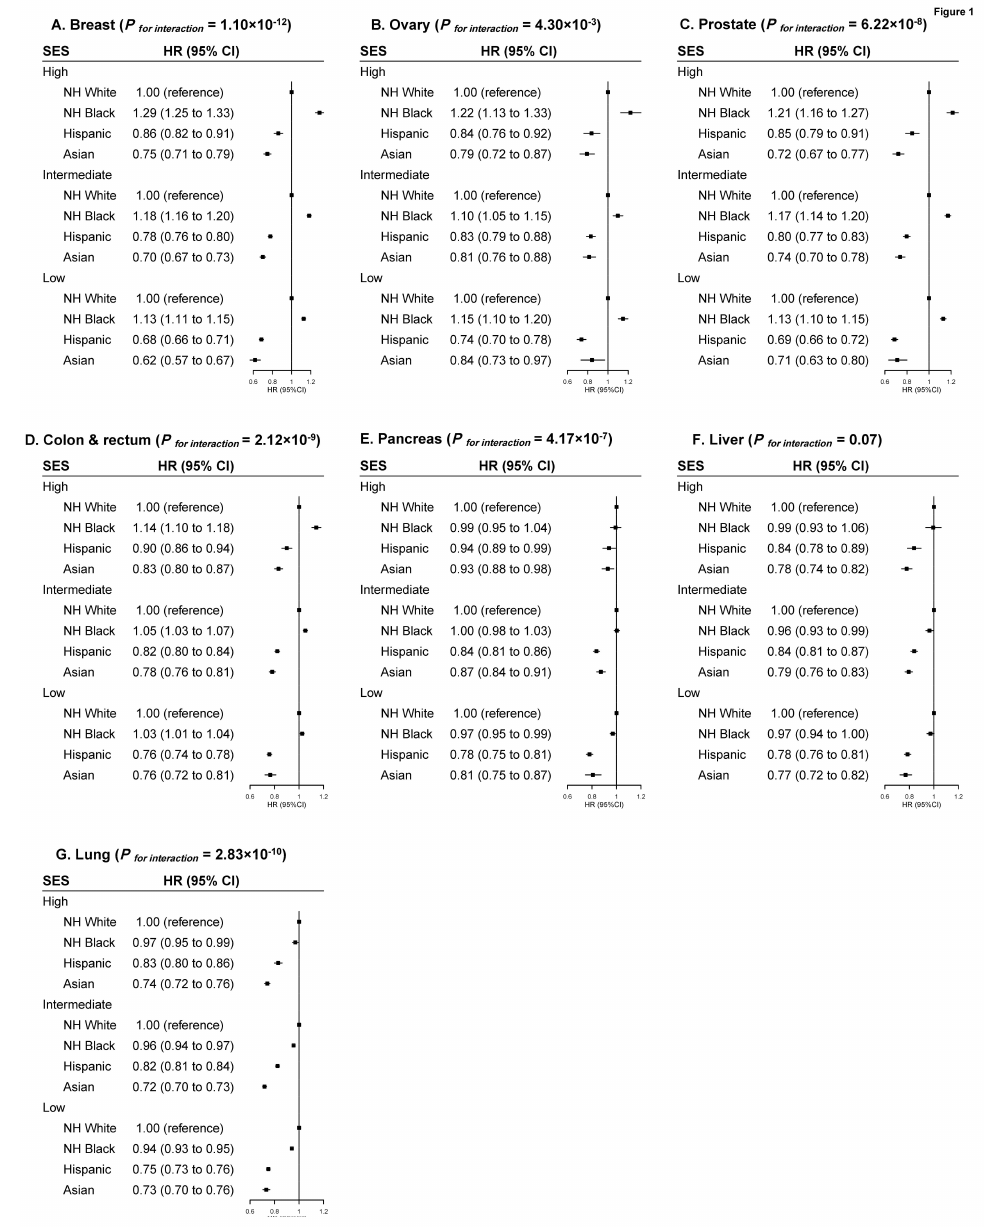
Figure 1. Multivariable-adjusted HRs and 95% CIs for Total Mortality Associated with Race/ethnicity According to Socioeconomic Status (SES) in Major Cancer Types (( A ) Breast Cancer; ( B ) Ovarian Cancer; ( C ) Prostate Cancer; ( D ) Colorectal Cancer; ( E ) Pancreatic Cancer; ( F ) Liver Cancer; ( G ) Lung Cancer). The HRs and 95% CIs for total mortality associated with race/ethnicity according to Socioeconomic Status (SES) in major cancer types. The HRs and 95% CIs were adjusted for age, sex (if applicable), biology (histology type, grade, TNM stage, LVI, comorbidity; ER, PR, HER2 for breast cancer; CA 125 for ovarian cancer; PSA and Gleason grade for prostate cancer; CA 19-9 for pancreatic cancer; AFP, Fibrosis Score, INR for liver cancer; separate tumor nodules for lung cancer; primary site, CEA, circumferential resection margin for colorectal cancer), treatment factors (surgery, chemotherapy, interval between diagnosis to first treatment; and endocrine therapy, radiation, immunotherapy, if applicable) and access to care (insurance, facility type, region, urban/rural residence, distance to care, and year of diagnosis). p values for interaction between racial/ethnic groups and SES groups were derived from log likelihood tests. Abbreviation: HR, Hazard Ratio; CI, Confidence